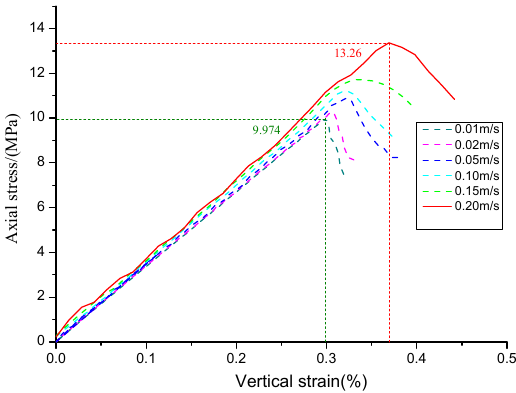
Figure 6. Stress–strain curves under different loading velocities.